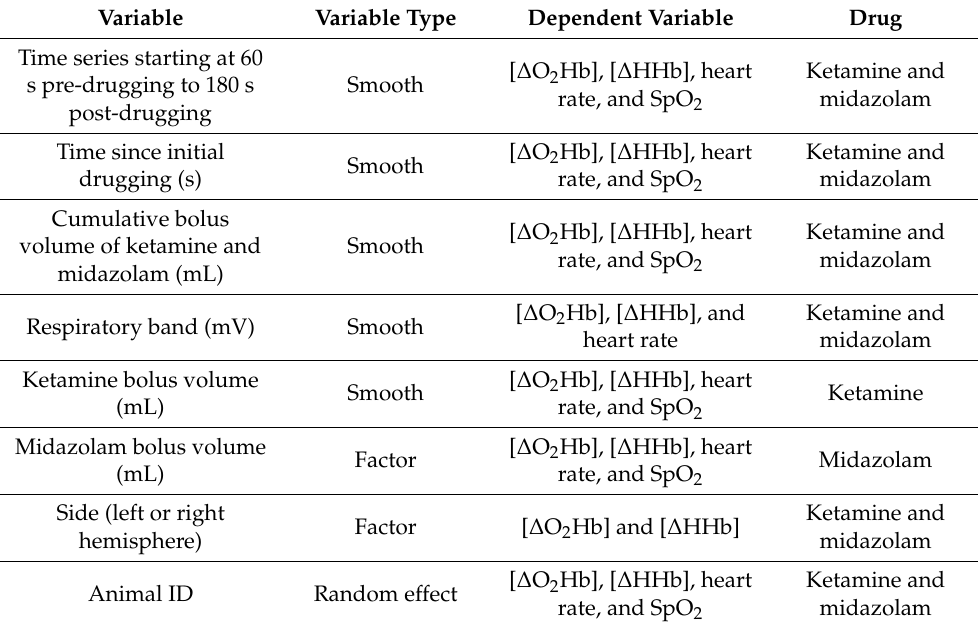
Table 1. The independent variables included in the model selection process for the response in [ ∆ O 2 Hb], [ ∆ HHb], heart rate, and SpO 2 to ketamine and midazolam administration. For each independent variable, the variable type (smooth function, factor variable, or random effect) and the dependent variable and drug for which it was included in model selection is